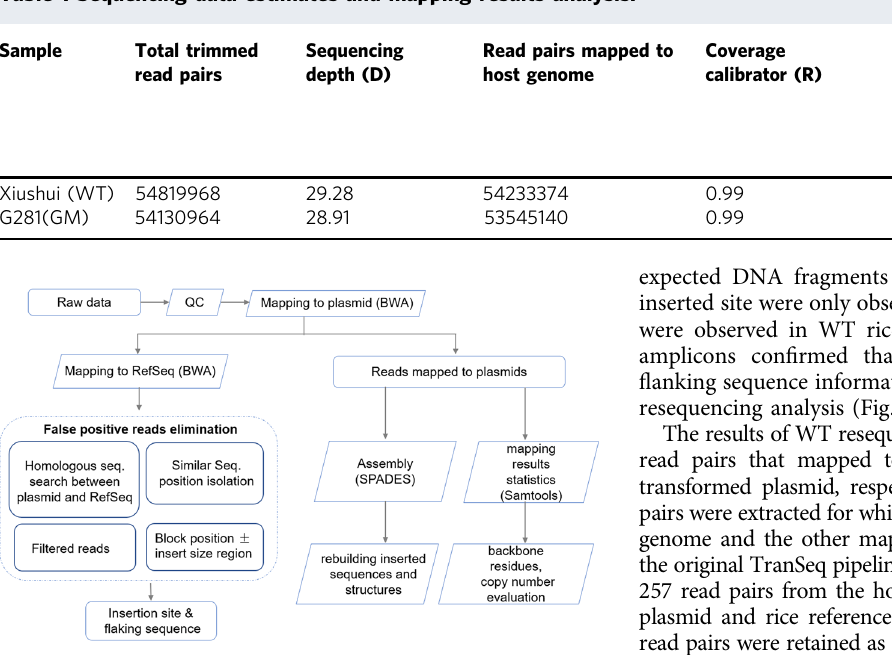
Table 1 Sequencing data estimates and mapping results analysis.